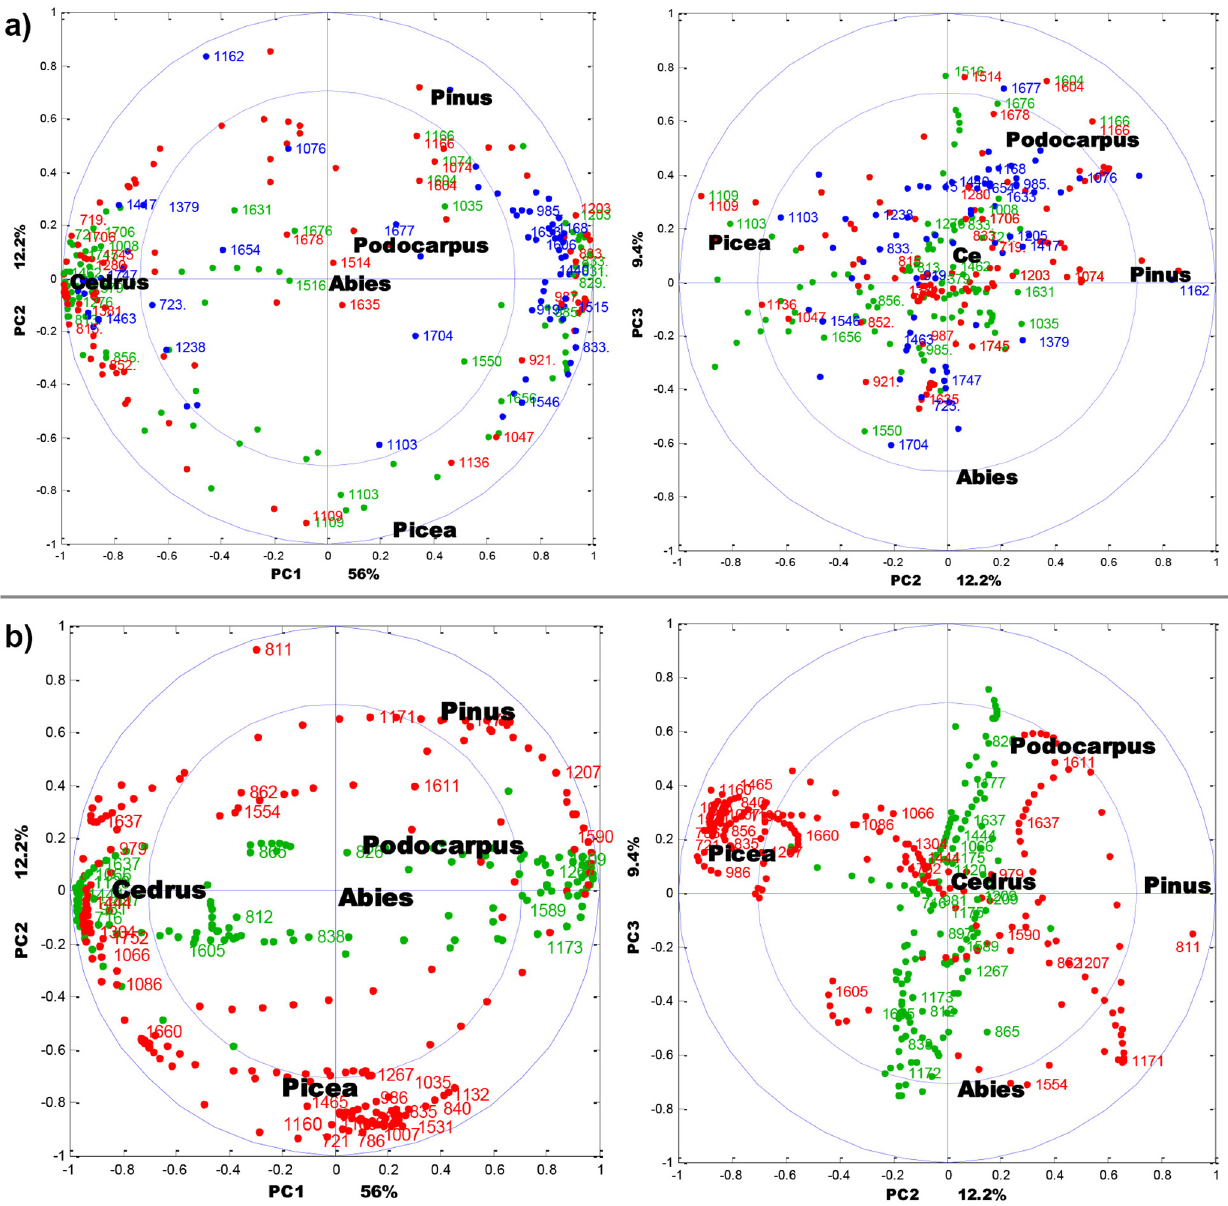
Fig 6. CPCA correlation loading plots for the first three principal components. (a) Correlation between pollen genera (black), FTIR of KBr pellets (blue), ATR of ground pollen (red) and ATR of intact pollen (green). (b) Correlation between pollen genera (black), Raman of corpus region (red) and Raman of saccus region (green). For the sake of clarity, only the selected variables are presented. The percent variances for the first five PCs are 56.0, 12.2, 9.4, 7.5 and